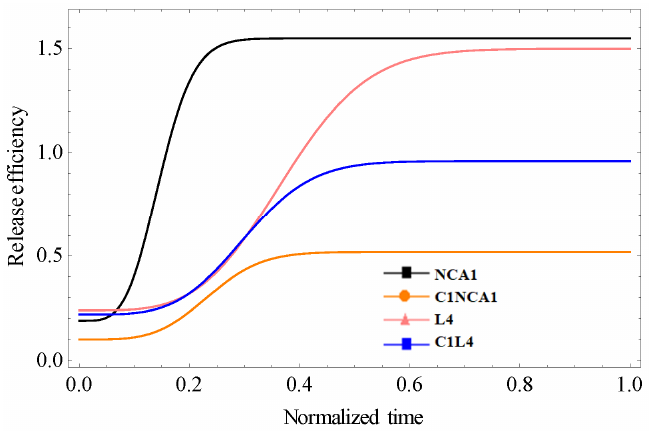
Figure 5. Comparative plots of experimental data and theoretical